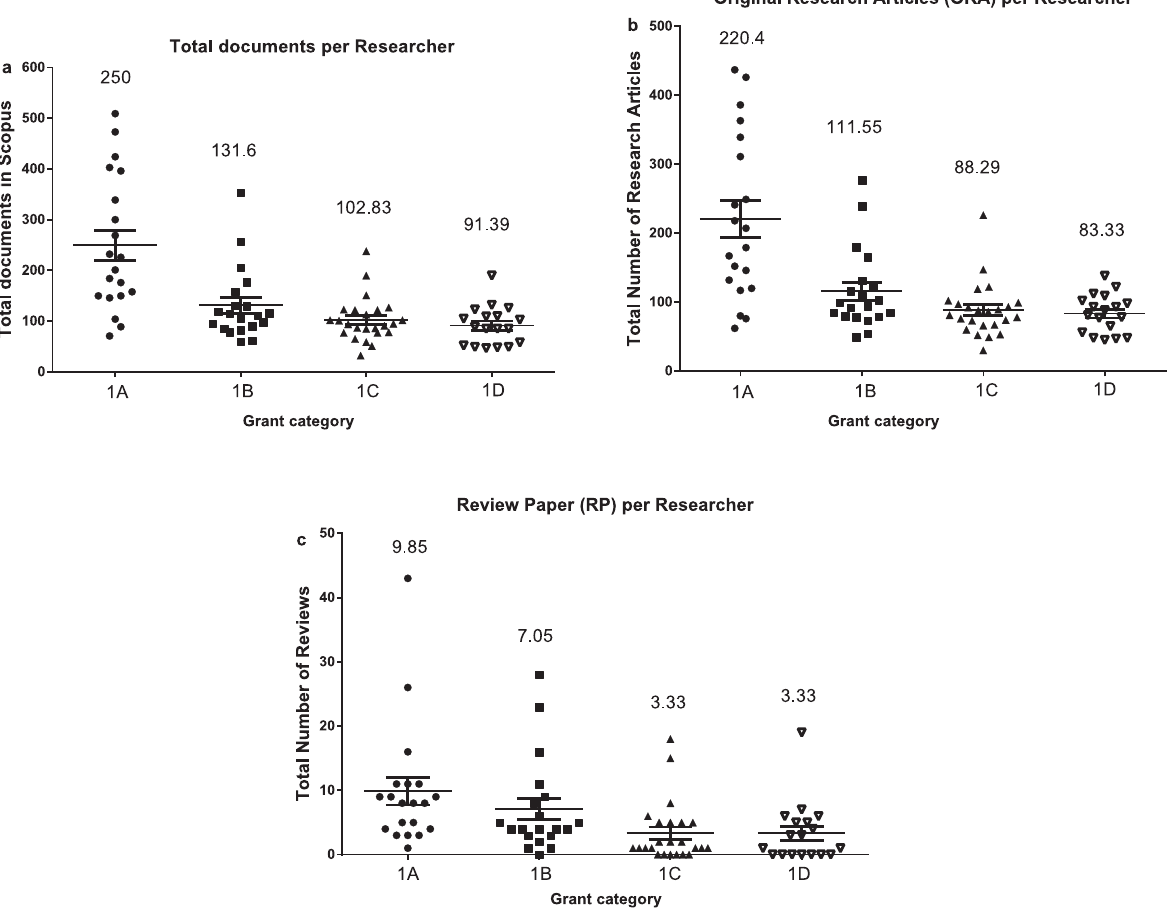
Figure 1 - Distribution of total documents (a) , original research articles (ORA) (b) and review papers (RP) (c) published by Brazilian researchers from CNPq grant category 1A-D in Pharmacology. The numbers above indicate the mean of total documents, ORA or RP per researcher.